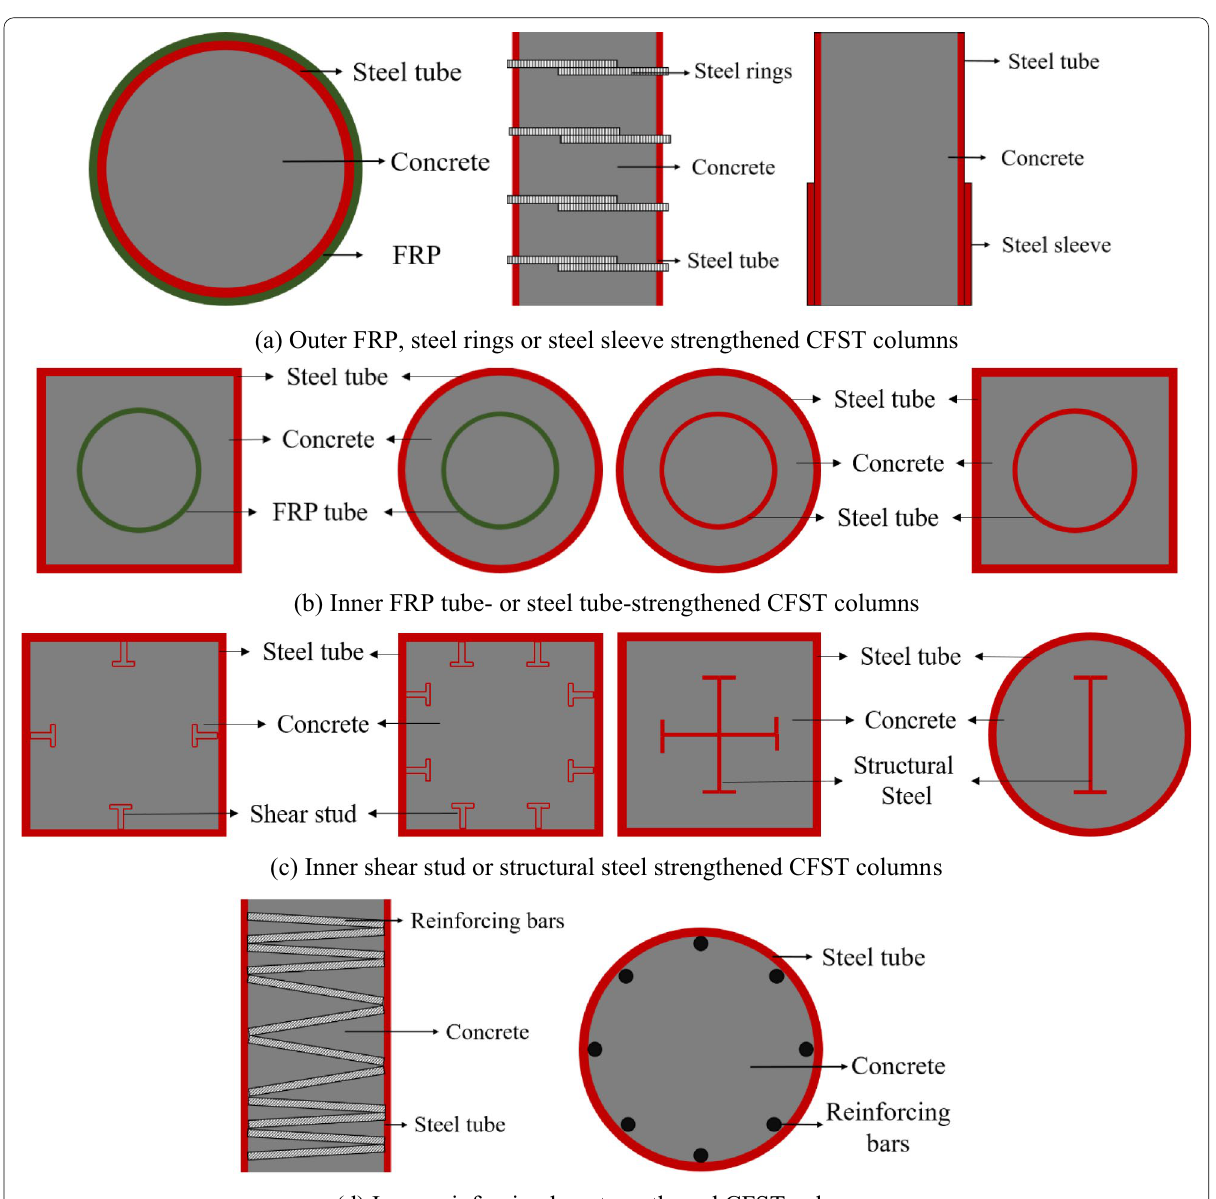
Fig. 1 Different strengthening methods of concrete-filled steel tube